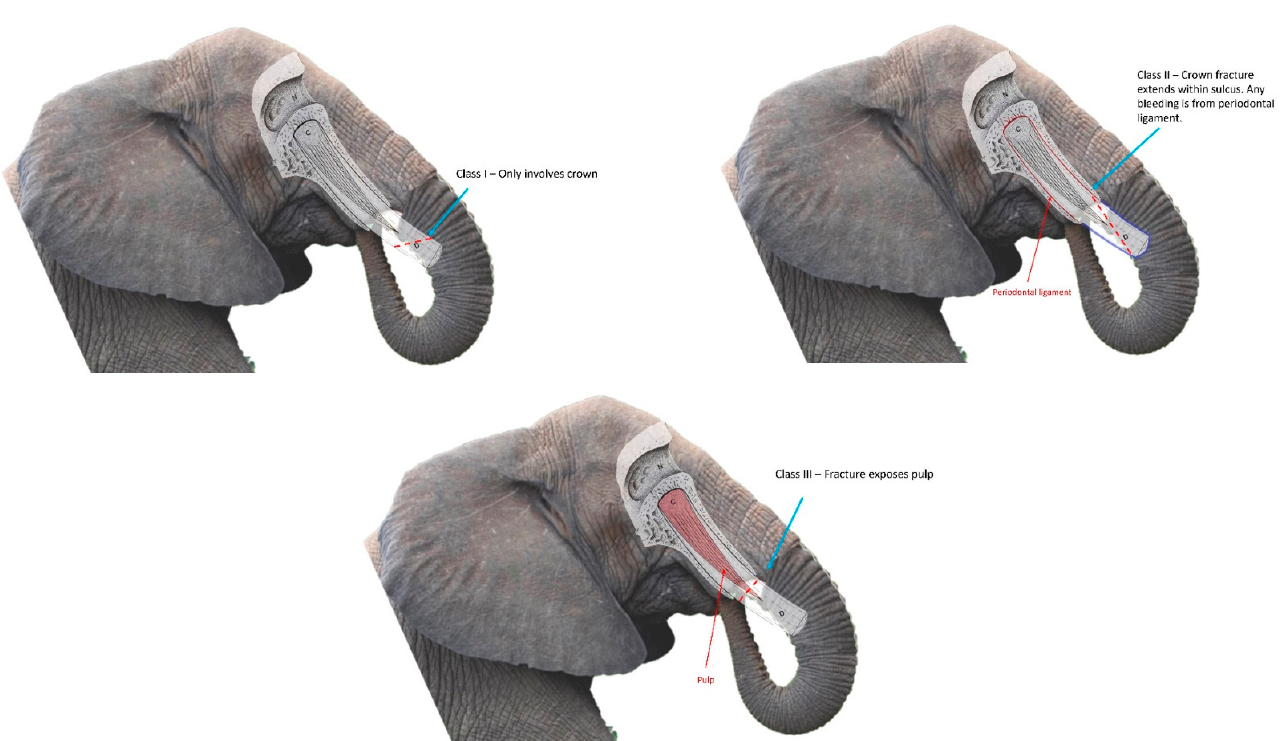
Figure 1. Diagrams illustrating tusk fracture classification system utilized in survey. Diagram modified from previous publication with permission [15].